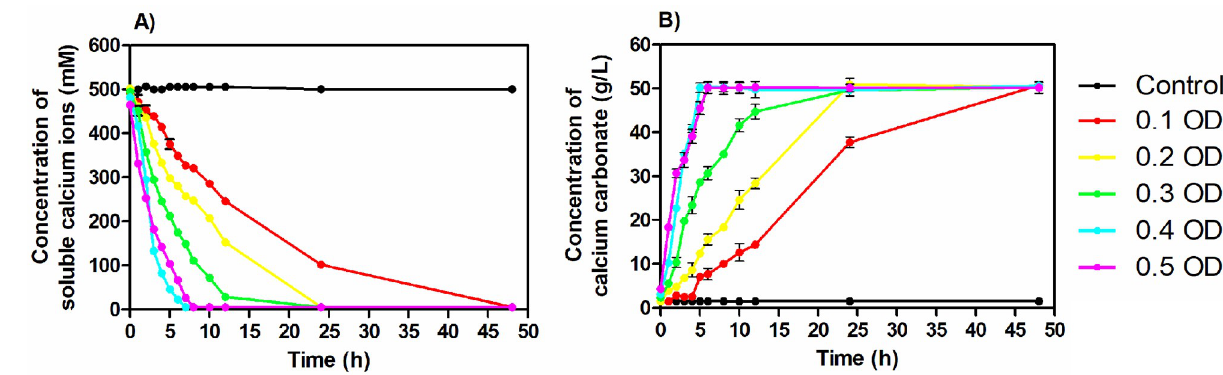
Fig 2. Concentration of soluble calcium ions (A) and calcium carbonate (B) over